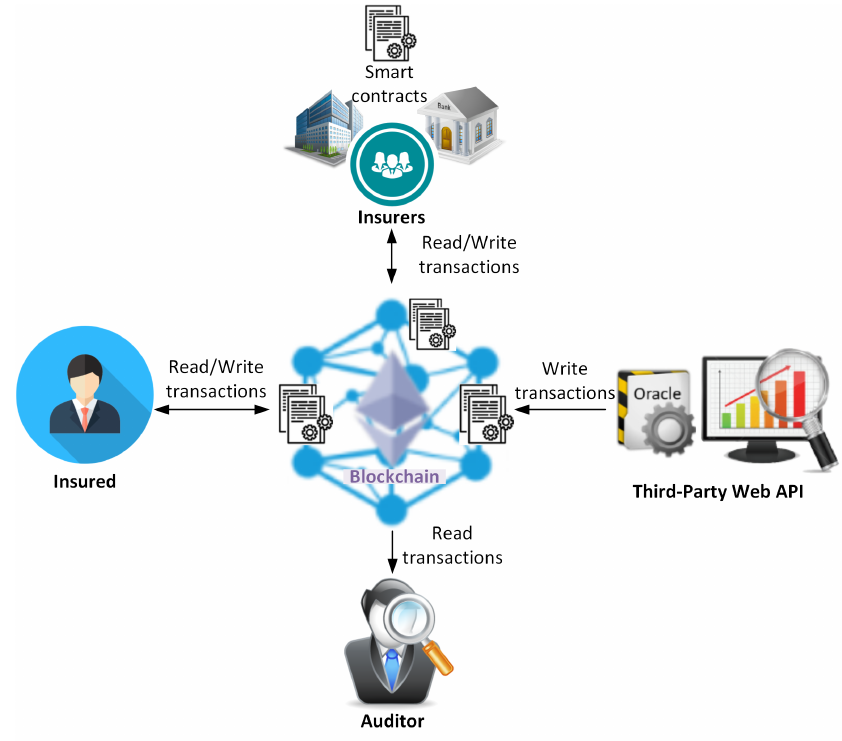
Figure 1. CioSy system model